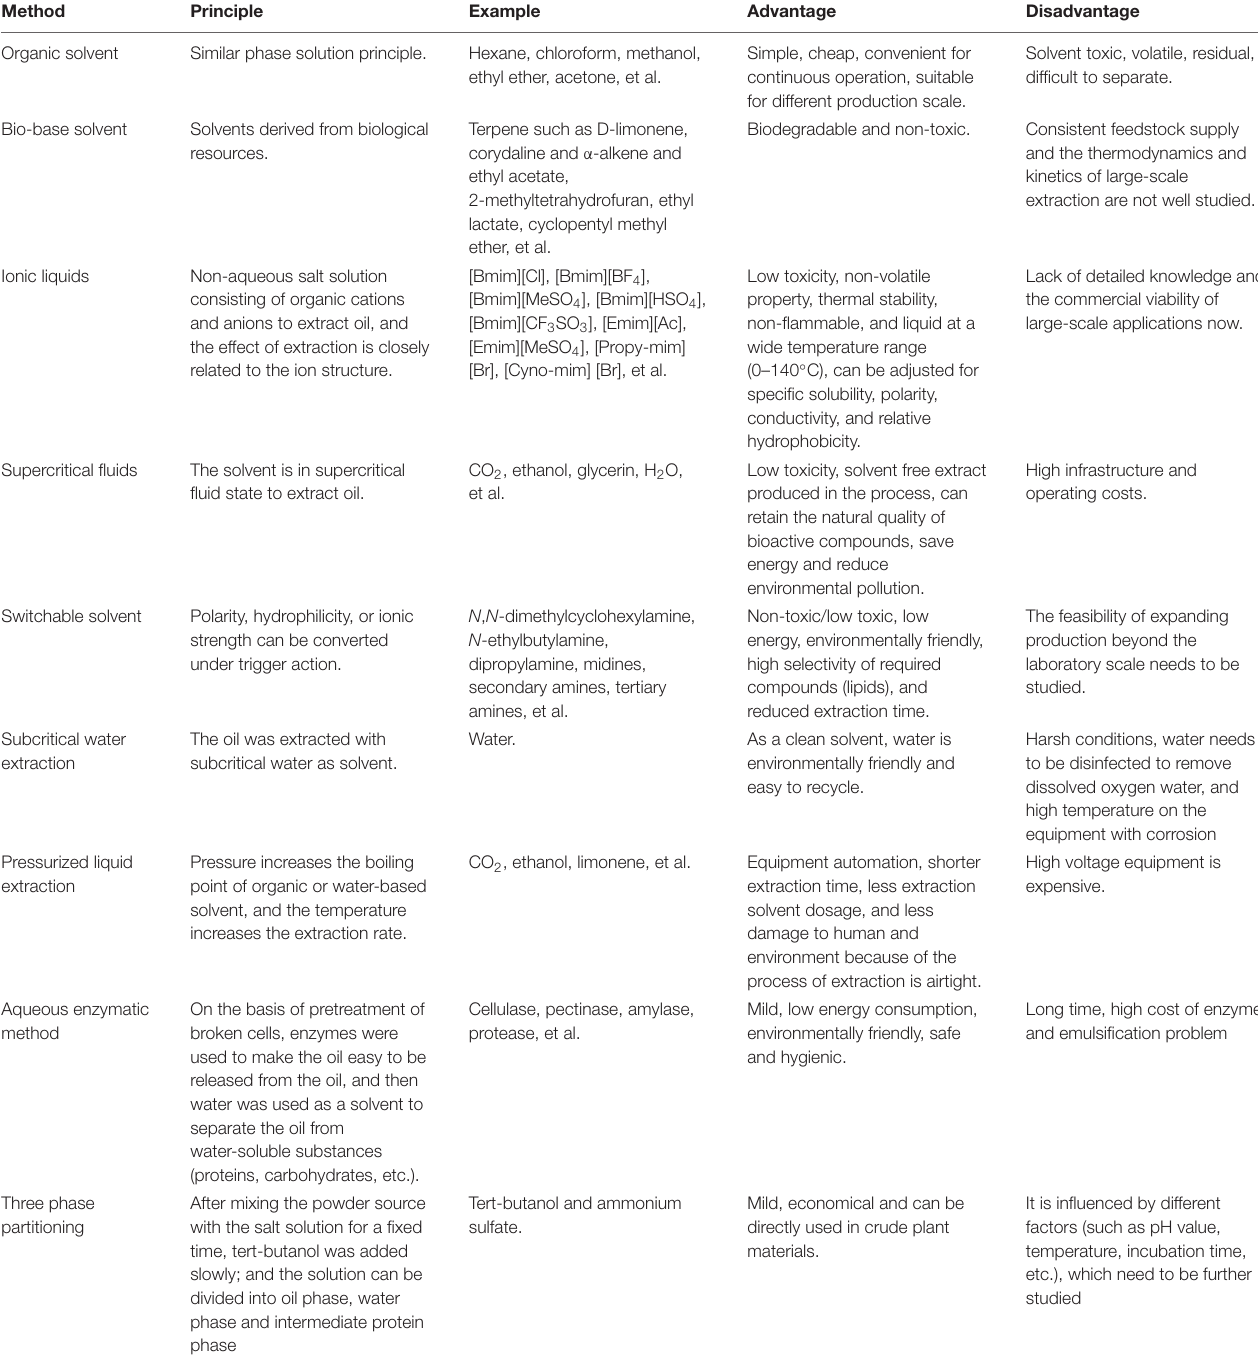
TABLE 3 | Comparison of different lipid extraction methods of microalgae (Enamala et al., 2018; Baskar et al., 2019; Karmakar and Halder, 2019; Li P. et al., 2019; Nagappan et al.,